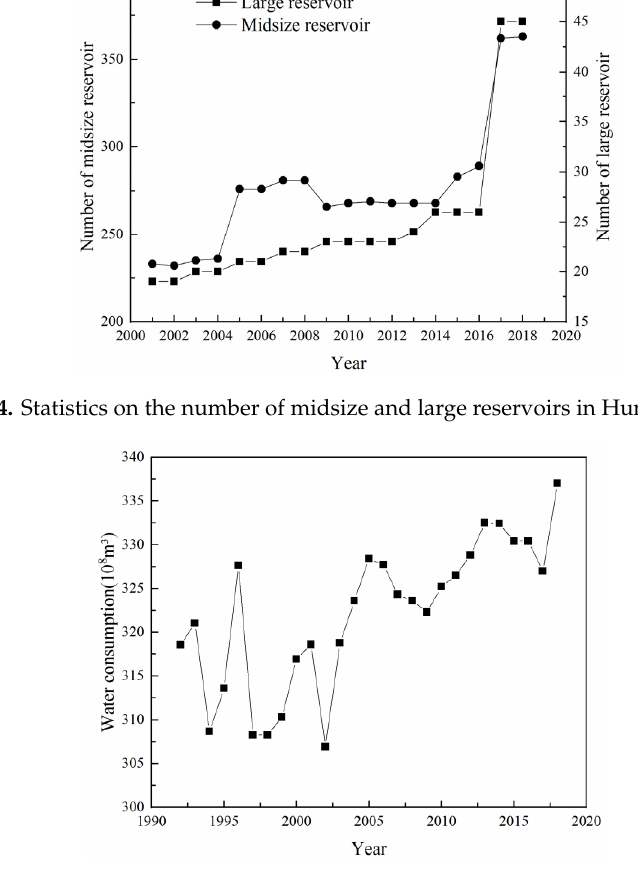
Figure 5. Annual water consumption of Hunan province.